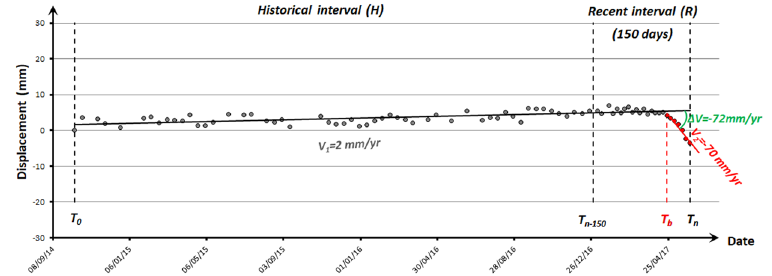
Figure 5. Identification of trend changes within the last 150 days in the displacement time series. An anomalous point is automatically highlighted as the difference between the deformation velocities (| Δ V|) recorded in the two-time intervals (T 0 –T b and T b –T n ) is > 10 mm/yr.